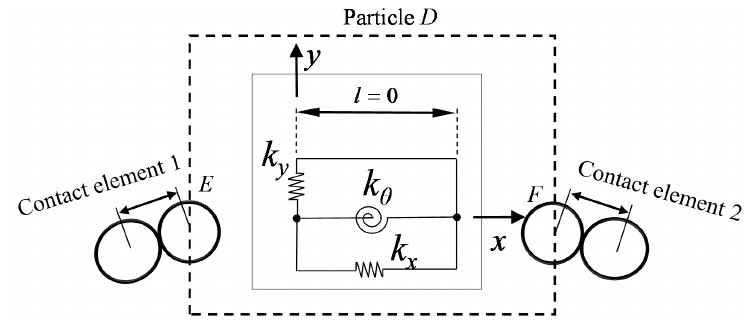
Figure 3. Zero-length spring element at a semi-rigid connection.